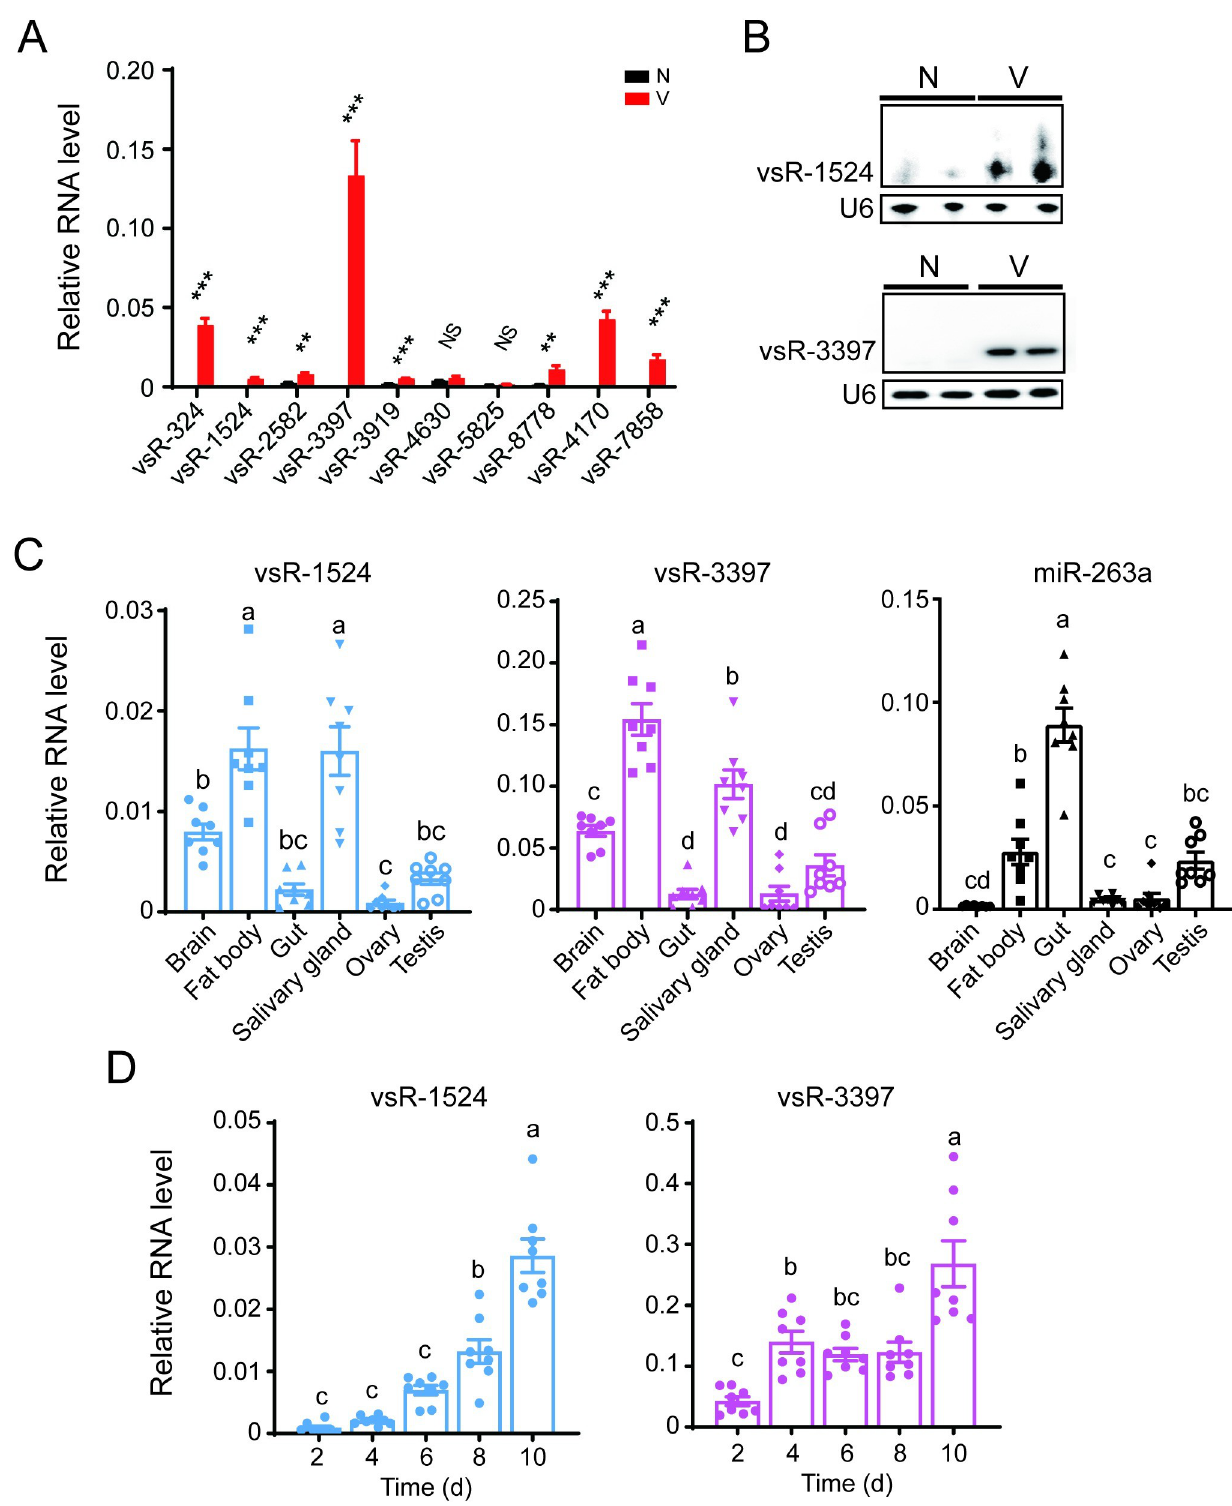
Fig 4. Identification of RSV vsRNAs putatively targeting primary miR-263a. (A) Relative RNA levels of the top ten most abundant vsRNAs in nonviruliferous (N) and viruliferous (V) fourth-instar planthoppers (n = 8). NS, no significant difference. �� , P < 0.01. ��� , P < 0.001. (B) Identification of vsR-1524 and vsR-3397 in N and V planthoppers by northern blot using biotin-labeled LNA oligonucleotide probes. (C) and (D) Relative RNA levels of